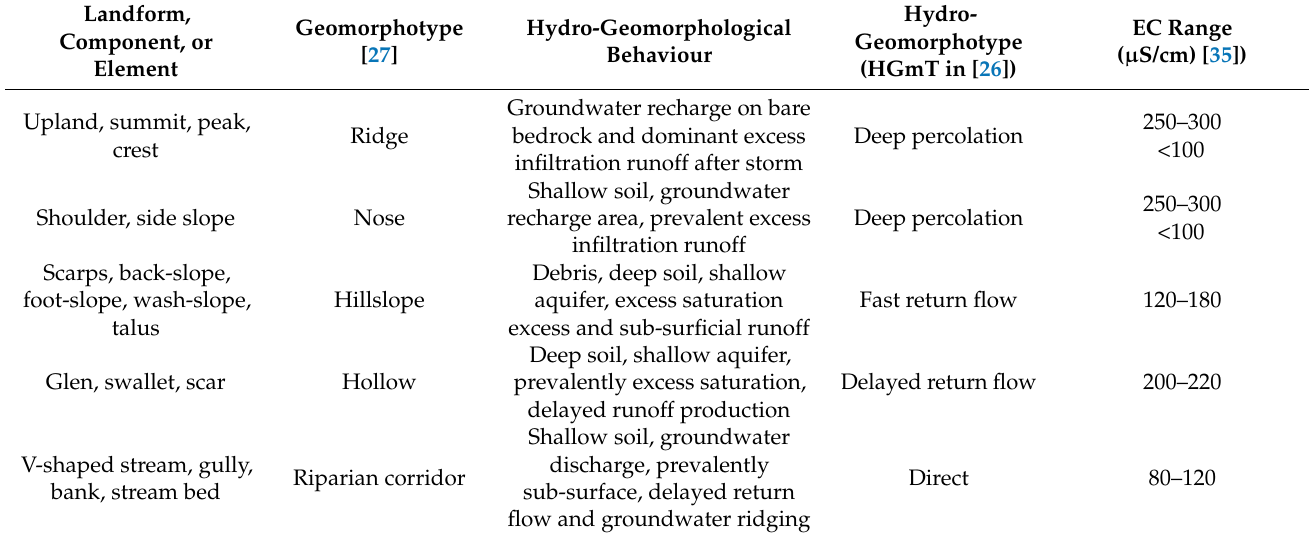
Table 2. Landform vs. hydro-geomorphotype correspondences (modified from